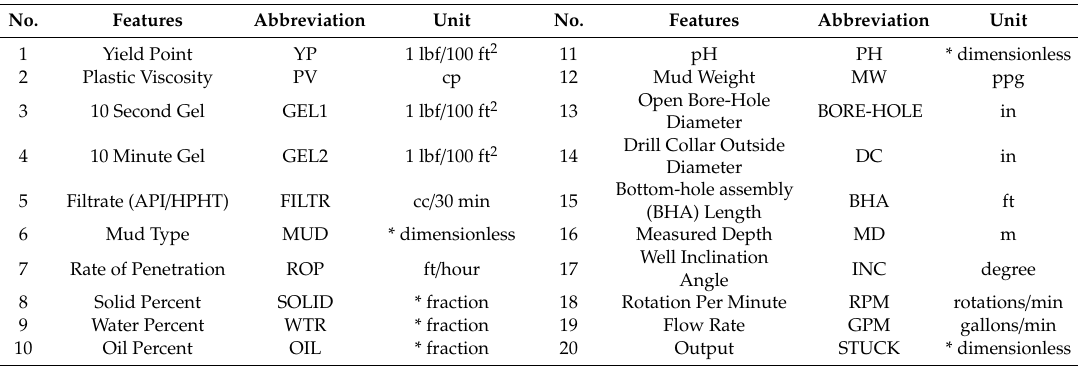
Table 3. Drilling parameters for model